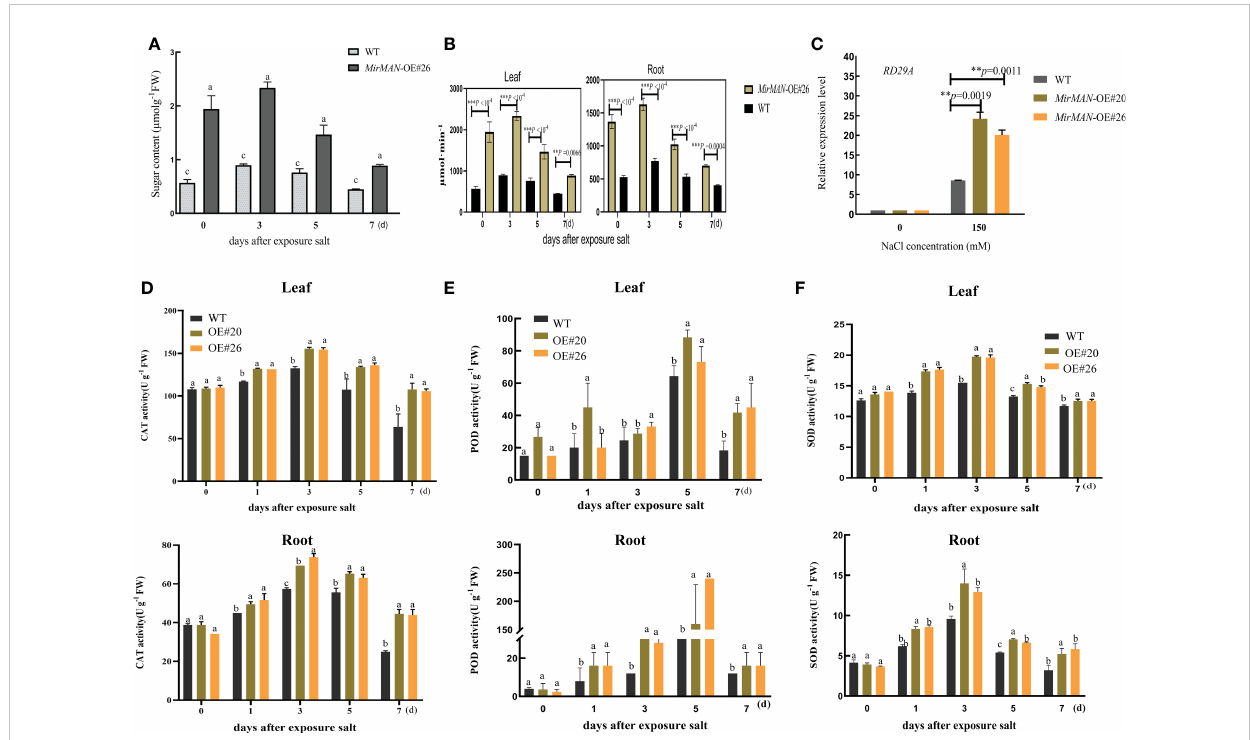
FIGURE 8 Salt resistance analysis of WT and transgenic lines of Arabidopsis plants. (A) Soluble sugar contents. (B) Endo- b -mannanase activity. (C) RD29A gene expressions after salt experiment. (D) CAT activity. (E) POD activity. (F) SOD activity. SOD, superoxide dismutase; POD, peroxidase; CAT, catalase; WT, wild type. Error bars indicate ± SD. Student ’ s t -tests were used to compare the measurements of OE lines with those from WT. **p< 0.01, *** P < 0.001. Letters indicate the results for comparisons across group using Tukey ’ s post hoc